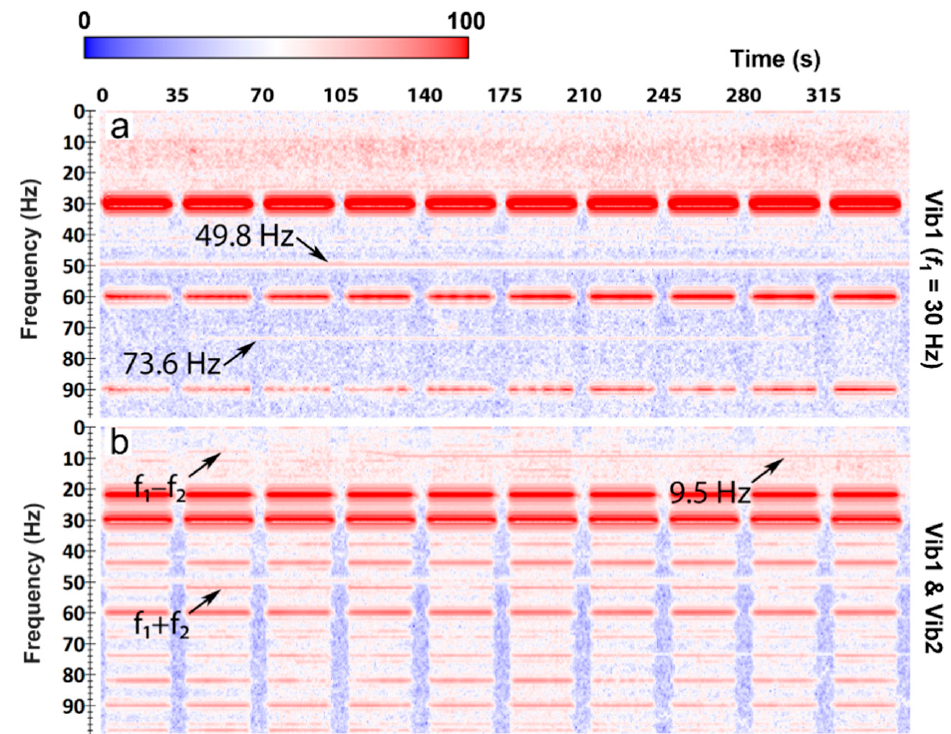
Figure 3. Time–frequency spectra of the data recorded by a single DAS channel in the well at a depth of ~60 m. ( a ) Vibrator 1 working solo at SP2; ( b ) two vibrators working simultaneously at SP1 and SP2.